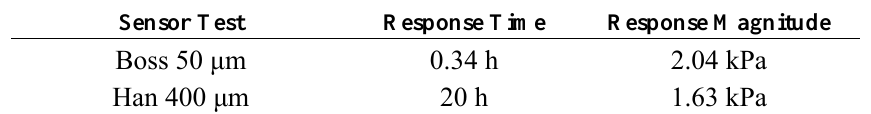
Table 2. A comparison of response times and magnitudes of the experiments